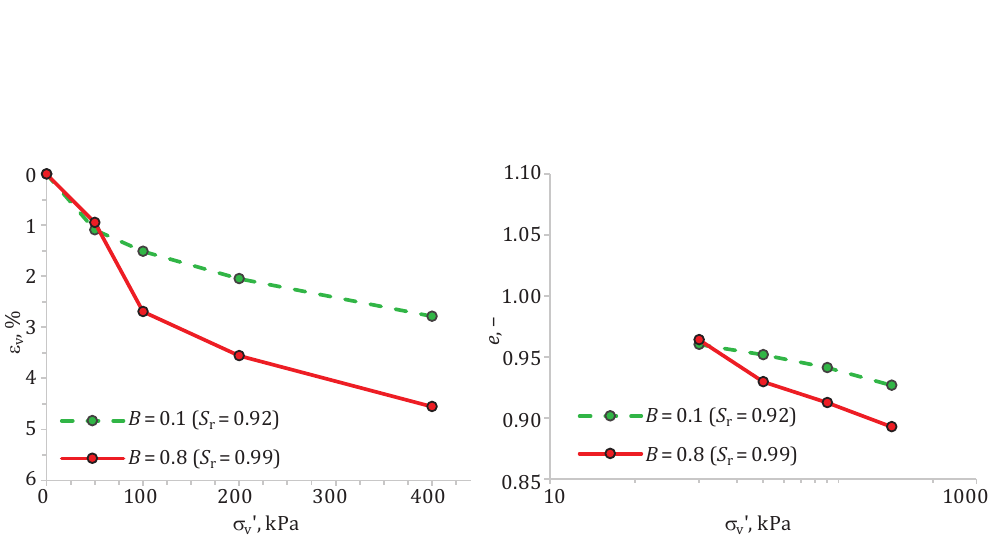
Figure 5. Vertical compression ε v , % versus pressure σ v ’, and void ratio e versus log pressure σ v ’ plots of saturated and non-saturated fly ash with 5% of bentonite